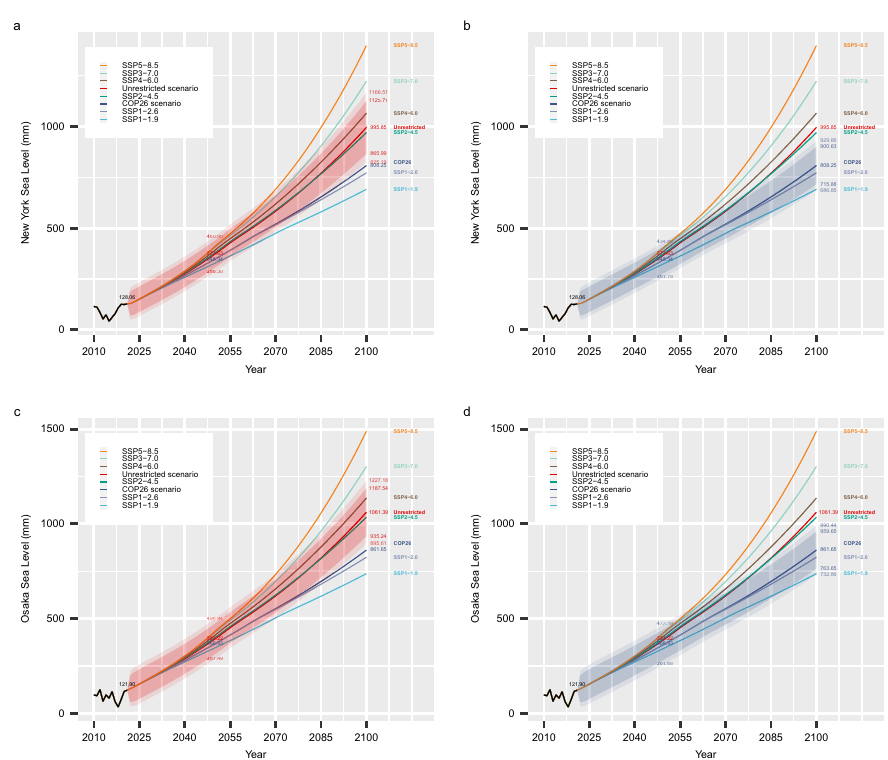
Figure 4. Regional mean sea level (RMSL) rise projections. The New York City ( a , b ) and Osaka ( c , d ) regional sea level rise projections under the unrestricted scenario (red), the COP26 scenario (grey), SSP5-8.5 (orange), SSP3-7.0 (light-green), SSP4-6.0 (brown), SSP2-4.5 (dark-green), SSP1-2.6 (light-grey) and SSP1-1.9 (light-blue) from now till 2100, the uncertainties (forecast interval) under the unrestricted and the COP26 scenarios were shown by the red and grey shaded area. For unrestricted and COP26 forecast, values of the expected means and the 95% and 99% forecast intervals are shown for 2050 and 2100 respectively. Historical data before 2022 are shown in black. The projections of the regional mean sea level are based on the ARDL models in Method